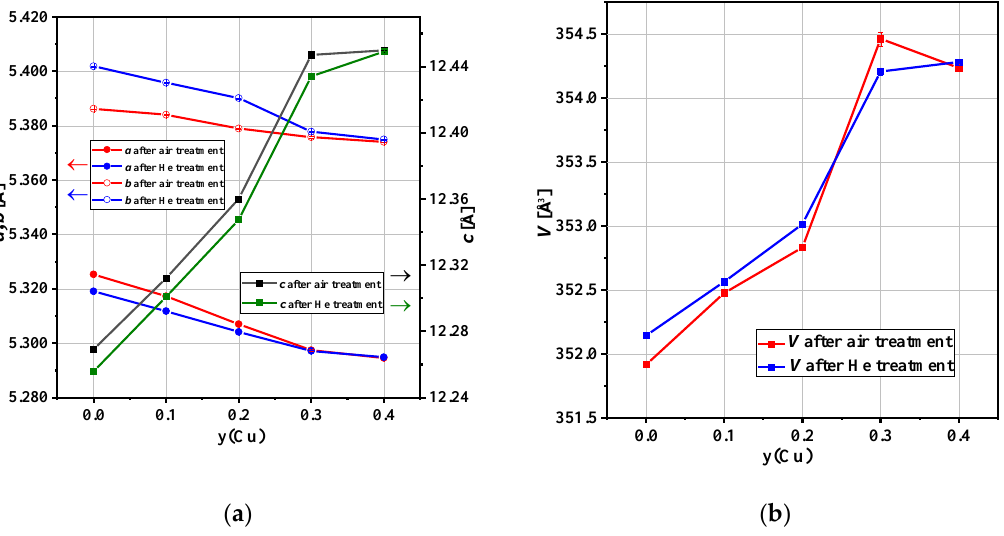
Figure 5. Concentration dependencies of the lattice parameters ( a ) and the unit cell volume ( b ) of the NCNCO00-NCNCO04 samples after the treatment in the synthetic air flow and in the He flow (error bars are not visible on the graph asthey are of the size of the symbols for the data points).